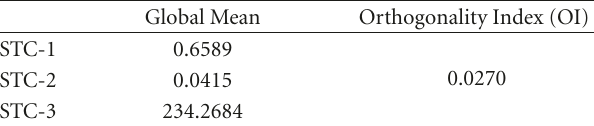
Table 1: Global mean of STCs and their